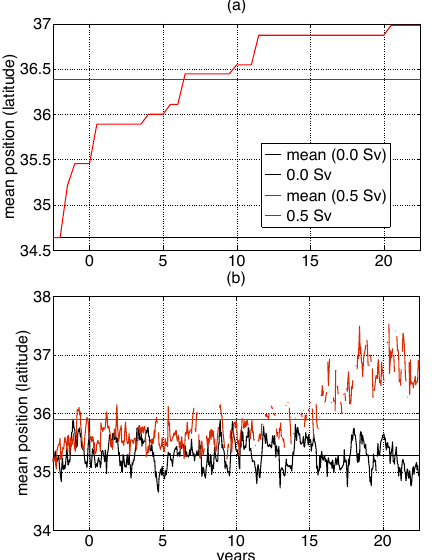
Figure 12. (a) Latitudinal position of the Gulf Stream separation from the LR control simulation (black) and the 0.5 Sv perturbation simulation (red). It is computed by identifying the path of the Gulf Stream from yearly- mean sea surface height (SSH) data. Next the separation latitude is defined as the mean latitude position within the interval [76 ◦ W-70 ◦ W]. The horizontal lines indicate the mean position of both time series. (b) Same as in (a) but for the HR 0.5 Sv simulation (monthly mean SSH data used).